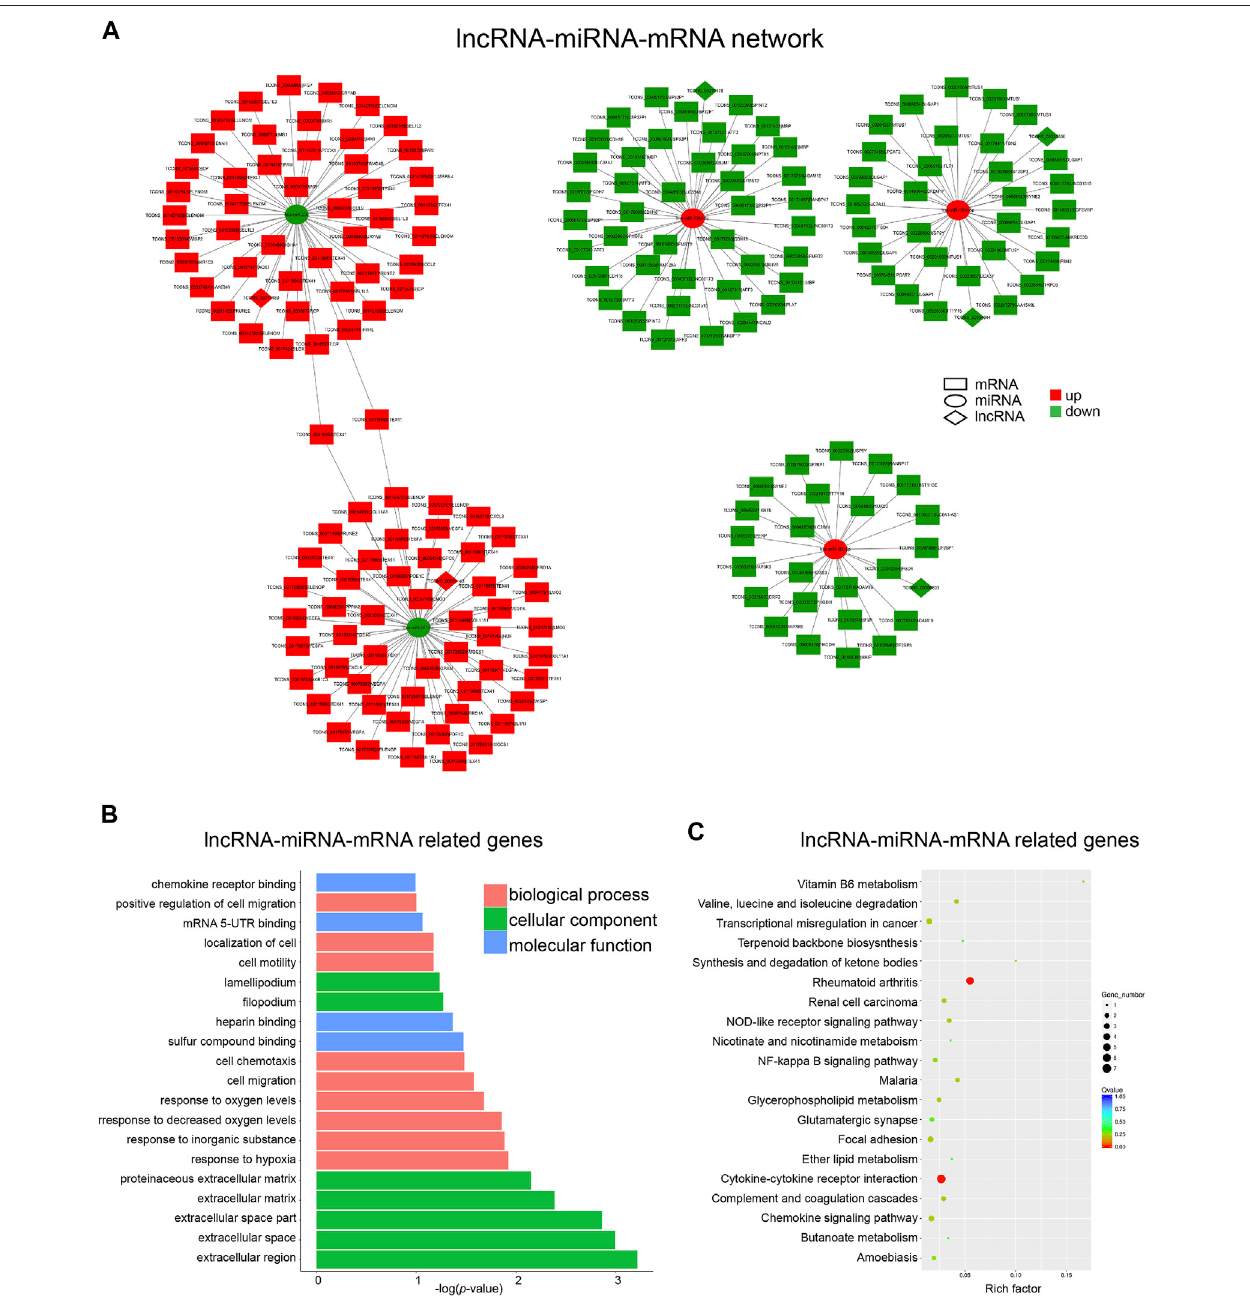
FIGURE 5 | Construction of the lncRNA-miRNA-mRNA Network. (A) Network analysis of lncRNA (diamond)-miRNA (round)-mRNA (square). Red and green representup-anddown-regulation,respectively. (B) Top20GOtermsanalyzedwithmRNAsinlncRNA-miRNA-mRNAnetwork. (C) Top20KEGGpathwayenrichment of mRNAs in lncRNA-miRNA-mRNA